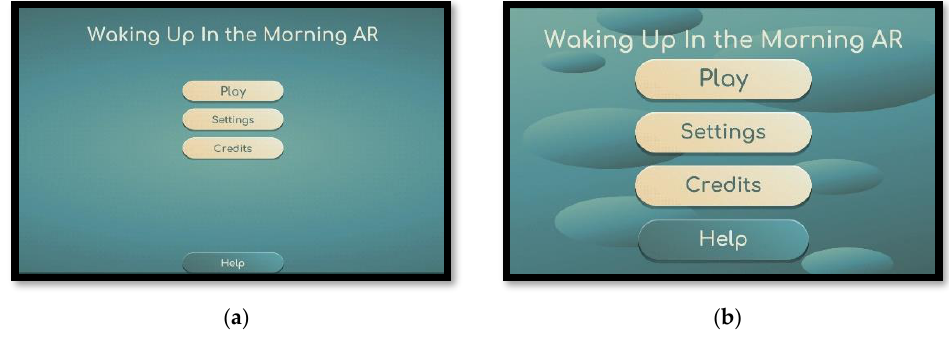
Figure 35. Improvement UI: ( a ) before evaluation; ( b ) after